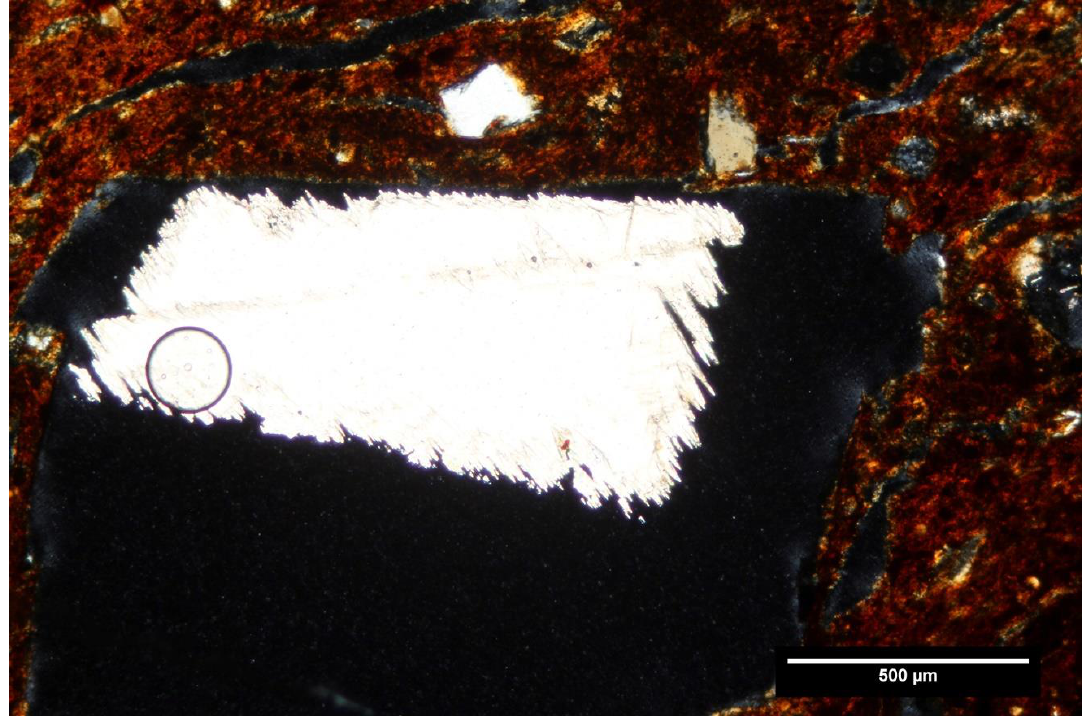
Figure 8. A large grain of partially eroded calcite within a pore in sample M50 from fabric C-1. Photomicrograph taken under crossed-polars by Jennifer Meanwell.